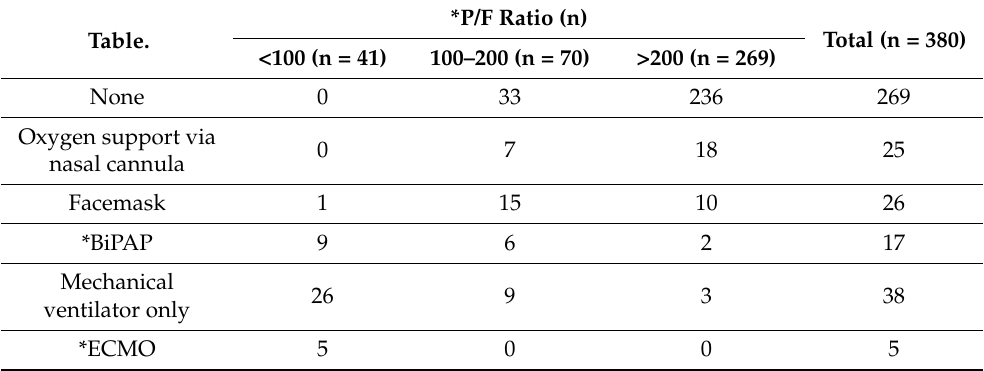
Table 2. Respiratory support required among leptospirosis patients according to P/F